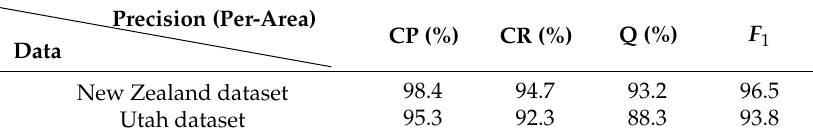
Figure 13. Building extraction at the per-pixel level. ( a ) Results of New Zealand dataset; ( b ) Details in New Zealand dataset; ( c ) Results of Utah dataset. Table 4. Evaluation results of building extraction at the area